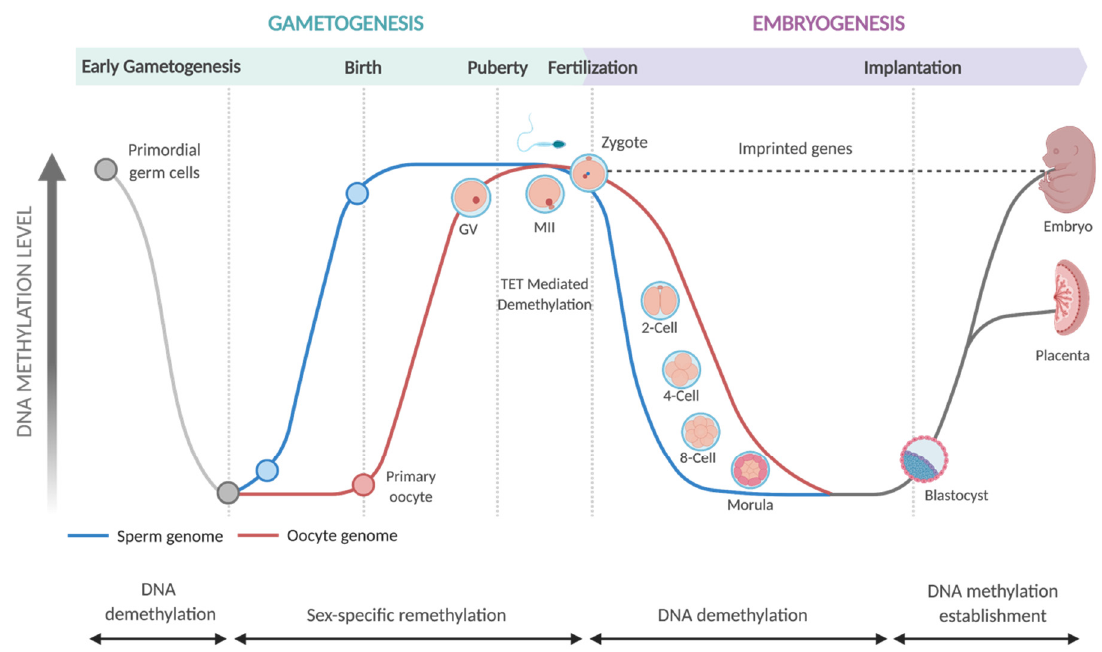
Figure 2. Changes in DNA Methylation during Mammalian Development. See text above for further details. Figure adapted from the templates library available at Biorender.com accessed on 8 Decem- ber 2021.